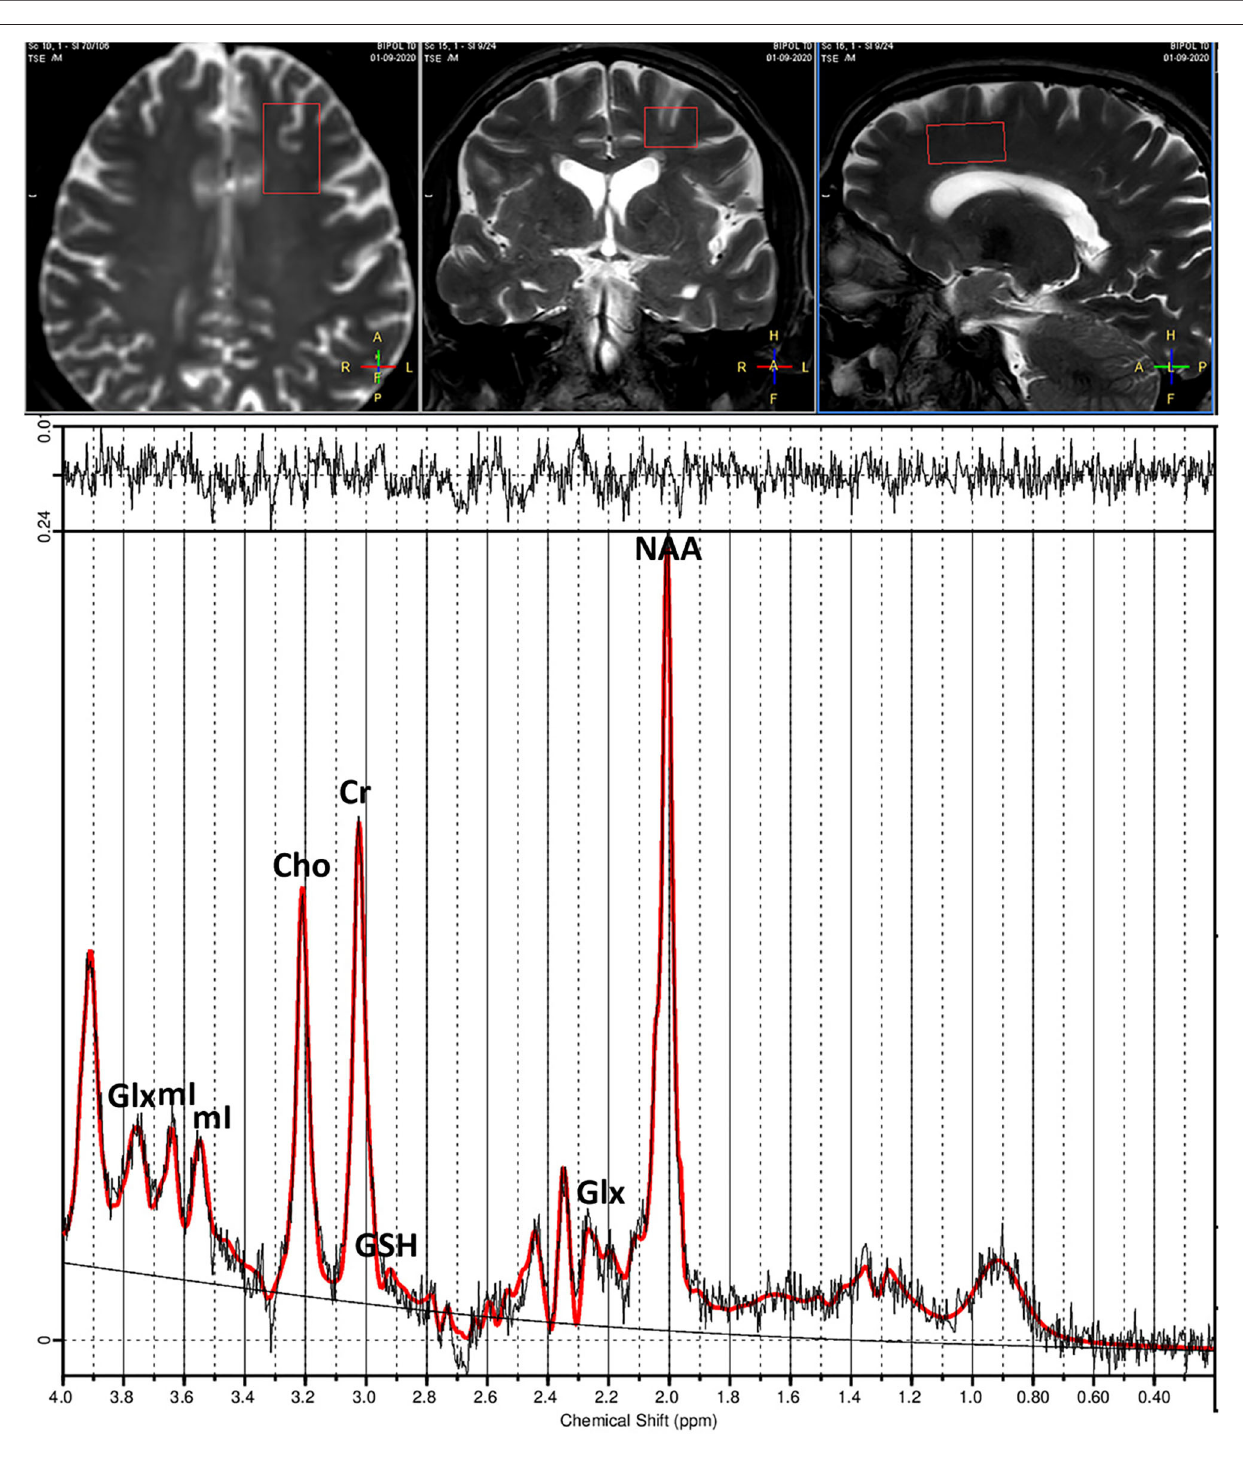
equivalent to maximizing the λ log-likelihood. The algorithm function was solved through the coordinate descent algorithm as implemented in MATLAB